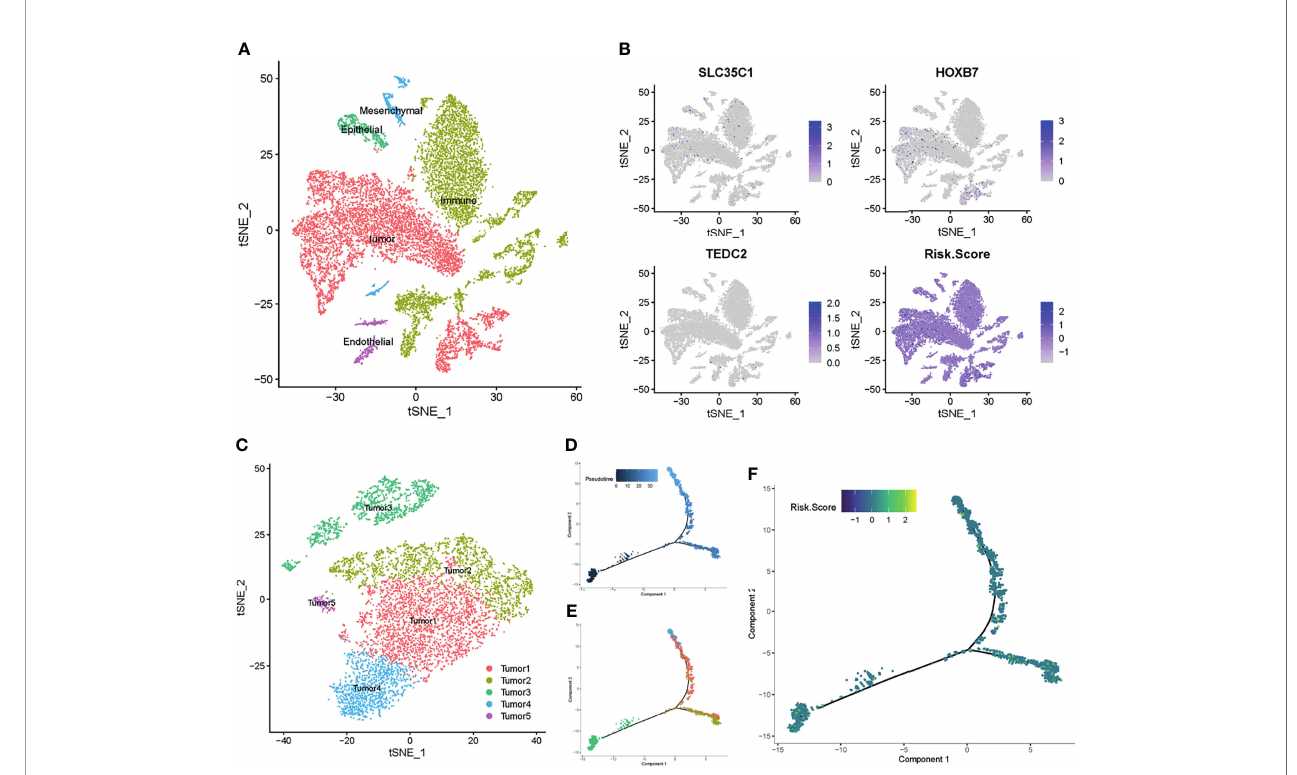
FIGURE 7 | Prognostic expression pro fi le based on single-cell sequencing analysis. (A) Composition and distribution of single cells from GSE150321. (B) The distribution pro fi le of SLC35C1 , HOXB7 , TEDC2 , and risk score for each cell by the t-SNE plot. (C) t-SNE embedding of the tumor cells. (D, E) Pseudotime and trajectory analysis revealed the tendency curve from tumor 3 cluster to tumor 4 and tumor 1 clusters. Y-axis means the value of principal component 1 (the fi rst principal direction of maximum sample change), and X-axis means the value of principal component 2 (the second principal direction of maximum sample change). (F) The expression pro fi le of risk score annotated in pseudotime and trajectory plot. t-SNE, t-distributed stochastic neighbor